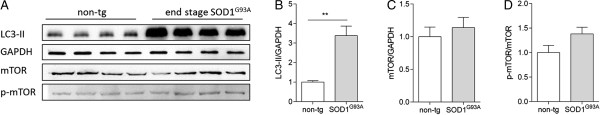
Autophagy is increased in ALS mouse spinal cord. Western blot analysis of age-matched spinal cords of non-transgenic (non-tg, n = 4) and end stage SOD1G93A mice (n = 4) (A). Quantification of Western blot signal of LC3-II for non-transgenic and end stage SOD1G93A mice (B), mTOR (C) and p-mTOR (D). **p < 0.01.